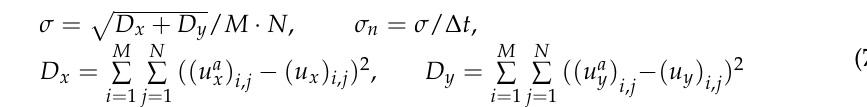
( f ) Figure 19. Evolution of deformation structures in the neck area for steel: ( a ) 0.040  =  = . All pseudo-images on ( a – f ) are obtained at T=1.